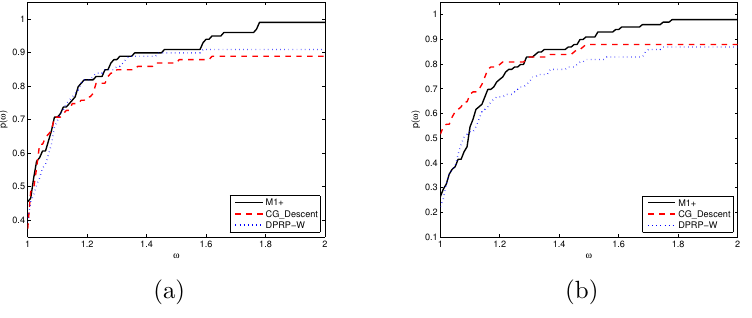
Figure 4. (a) Total number of function and gradient evaluations and (b) the CPU time performance profiles for M1+, CG Descent and DPRP-W.